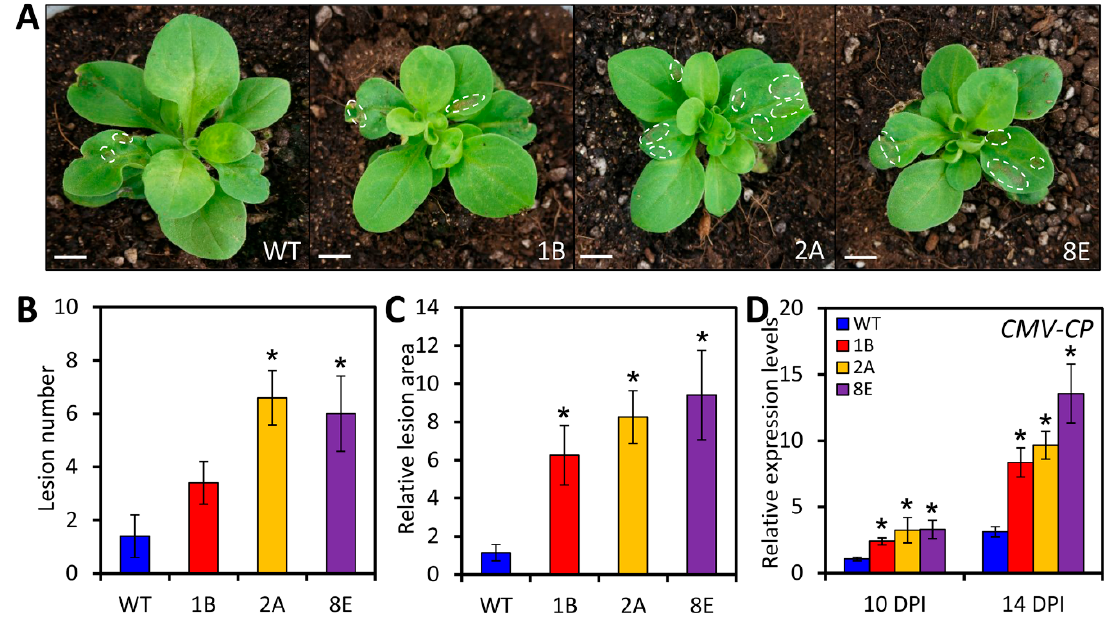
Figure5. Increasedsusceptibilitytocucumbermosaicvirus(CMV)infectionin LreEF1A4 -overexpressing transgenic petunia plants. ( A ) Disease symptoms of wild-type (WT) and transgenic lines (1B, 2A, and 8E) at 14 days post inoculation (DPI) with CMV. The plantlets at the four-leaf stage were used for viral inoculation. The necrotic lesions caused by CMV multiplication are marked in dashed circles. Scale bars = 5.0 mm. Number ( B ) and relative area ( C ) of necrotic lesions in systemically-infected leaves of WT and transgenic lines at 14 DPI. ( D ) Quantitative real-time polymerase chain reaction (PCR) analysis of CMV - CP transcripts encoding CMV coat protein in uppermost younger leaves of petunia plants at 10 and 14 DPI. 26S rRNA was used as an internal standard. Error bars represent standard error (SE) of the mean from three independent biological replicates. Asterisks indicate statistical significance as calculated by Student’s t -test at p <